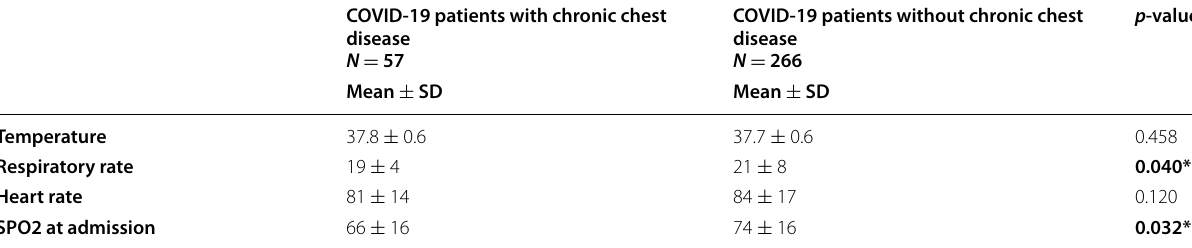
Table 3 Difference in vital signs between COVID-19 patients with CRD and patients without CRD